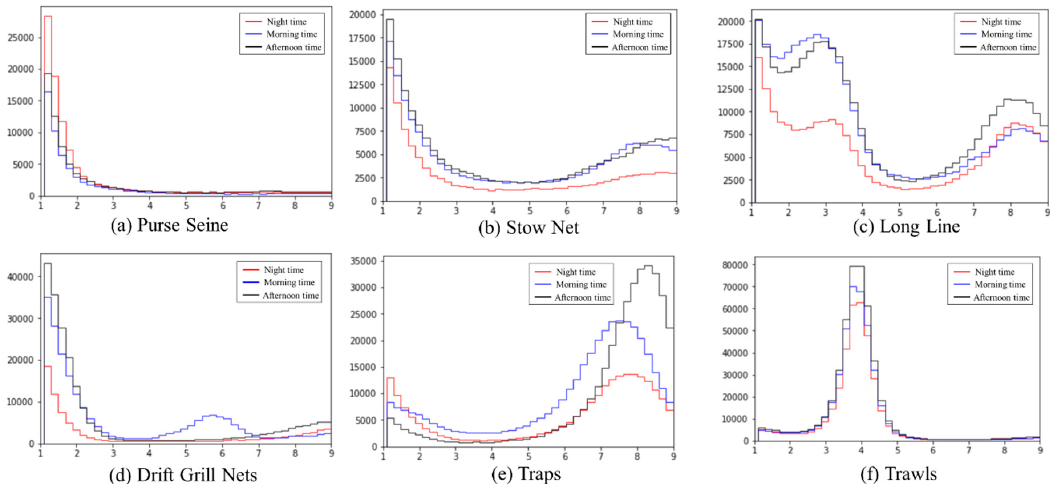
Figure 3. Ship speed distributions for fishing gear types over the time spans: the morning time span of 5:00 to 12:00 in blue, the afternoon time span of 12:00 to 20:00 in black, and the night time span of 20:00 to 5:00 in red.